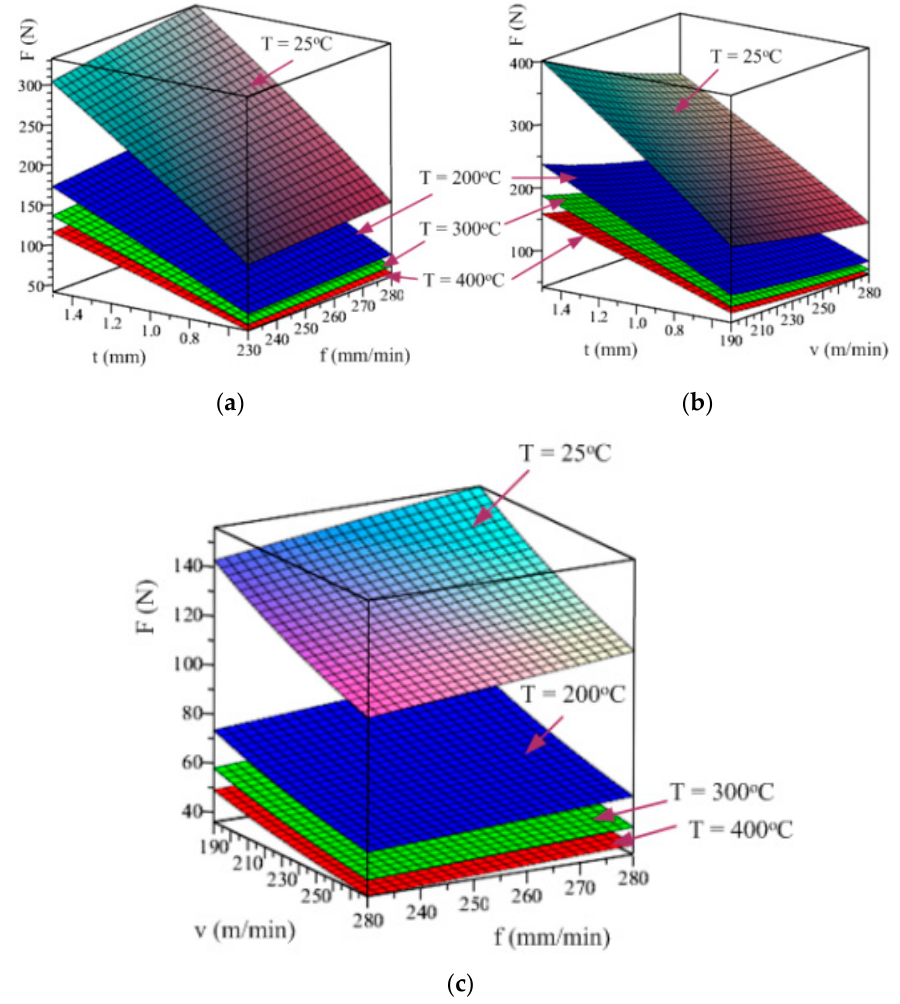
Figure 11. The relationship between F with V c , f and t at different temperatures ( a ) with fixed cutting speed, ( b ) with fixed feed rate, ( c ) with fixed cutting depth.